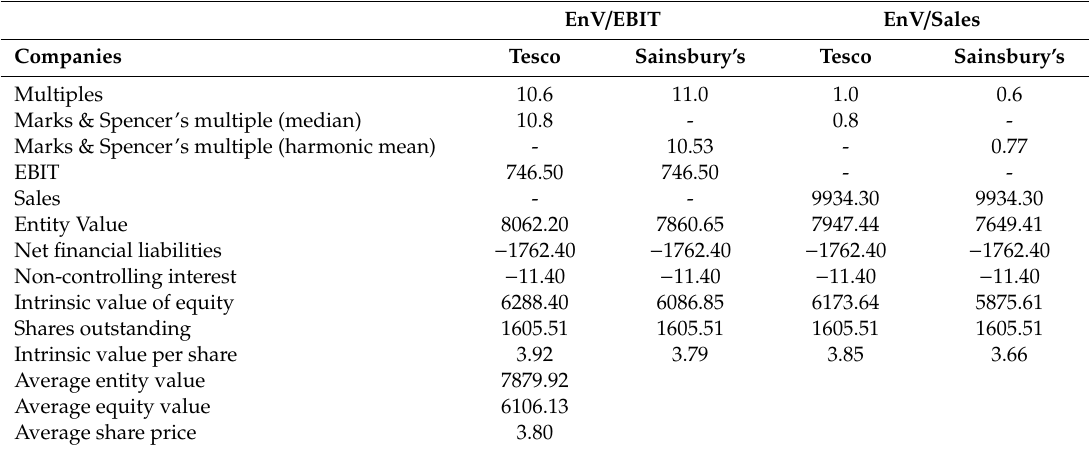
Table 3. Results of multiple-based valuation: left column calculation using median, while right column is using the harmonic mean, for either value